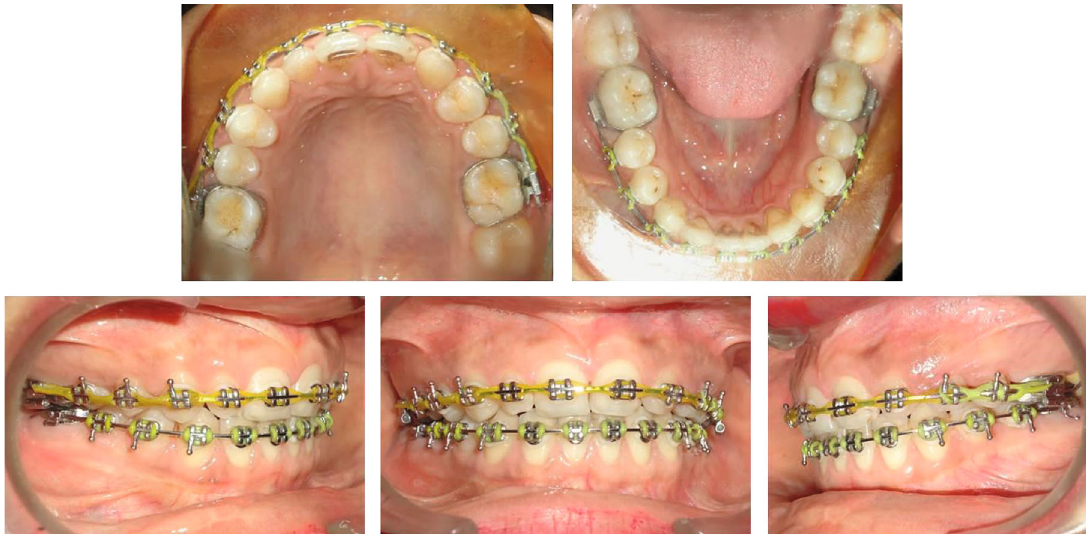
Figure 6: Midtreatment photographs.